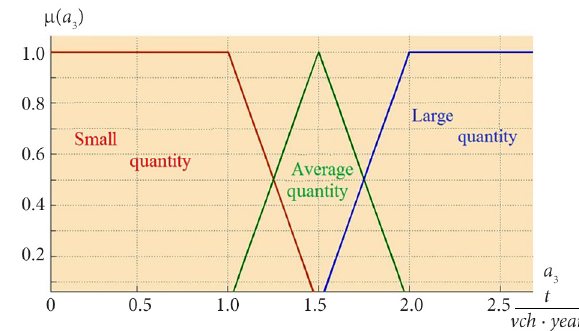
Figure 2. Example of phase-out of 2 CO emissions produced by private motor vehicles (primary indicator of 3 a